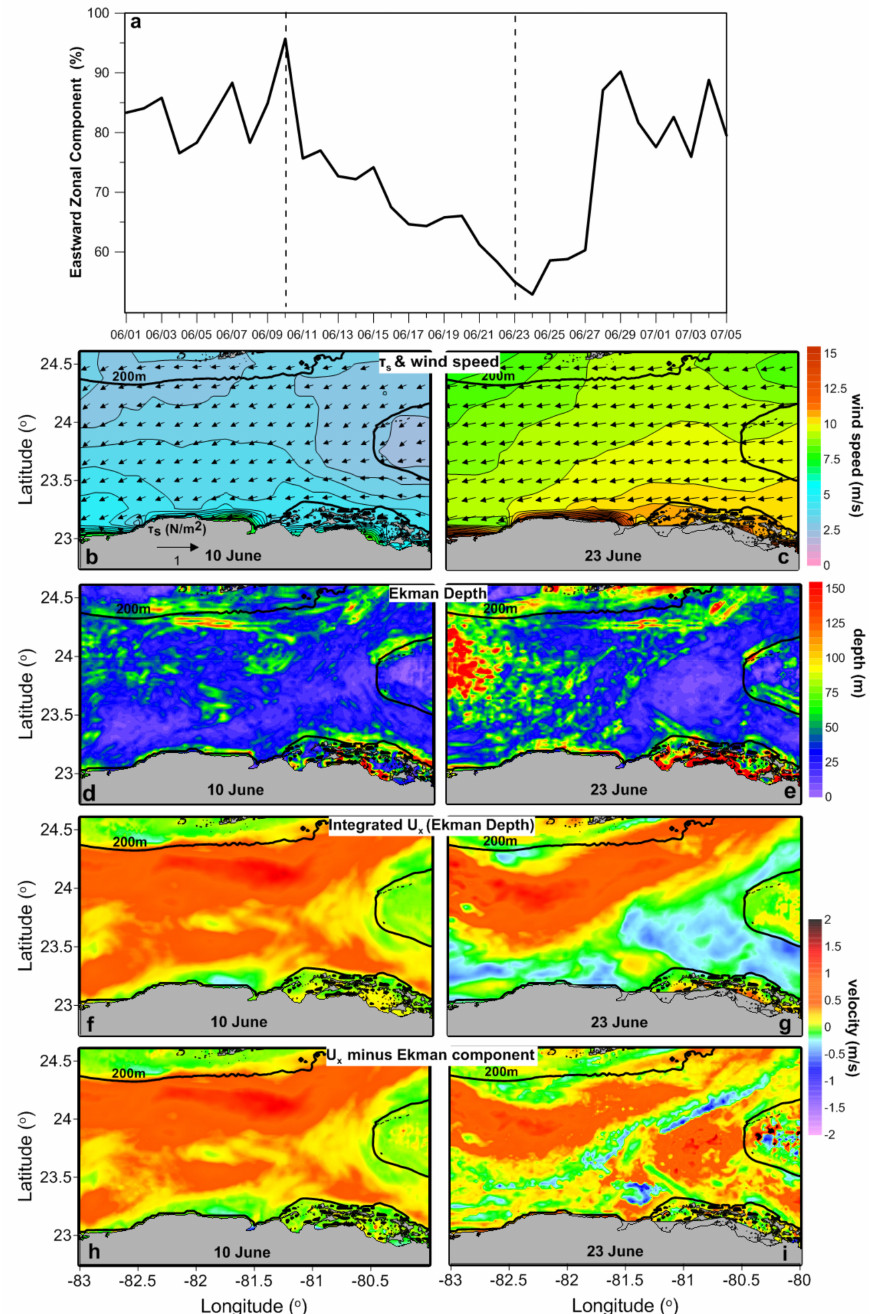
Figure 11. ( a ) Area (%) of the eastward zonal component of the surface currents before and during the period E3 (June 2010) over the Straits (region shown in panels ( b – i )), as derived from the GoM-HYCOM 1/50 model simulations. Horizontal distribution of ( b , c ) wind speed contours with stress direction. ( d , e ) Depth of the Ekman layer (m), ( f , g ) zonal east–west velocities (Ux) integrated over the Ekman layer (m/s) and ( h , i ) zonal east–west velocities integrated over the Ekman layer without the Ekman component of the current (m/s) for 10 June and 23 June during the E3 period. The dashed lines in ( a ) mark the two dates of 10 June and 23 June. The CubAN eddy evolved around 83 ◦ W (Figure